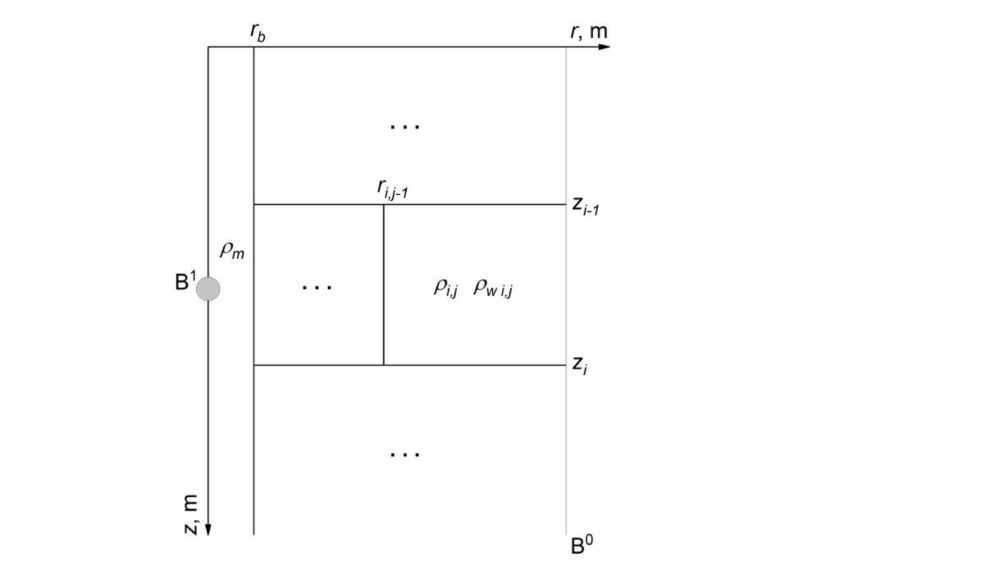
Figure 2. Axisymmetric model of the geological medium. Notations: r b —radius of the well, ρ m —resistivity of the drilling fluid, ρ i , j —resistivity of the j -th radial zone of the i -th formation, ρ w i , j —resistivity of the fluid of the j -th radial zone of the i -th formation, r i , j − 1 —radius of j-1 -th radial zone of the i -th layer, z i − 1 —coordinate of the i -th layer top, z i —coordinate of the i -th layer bottom, B 0 —outer boundary of the area, B 1 —surface of the measuring